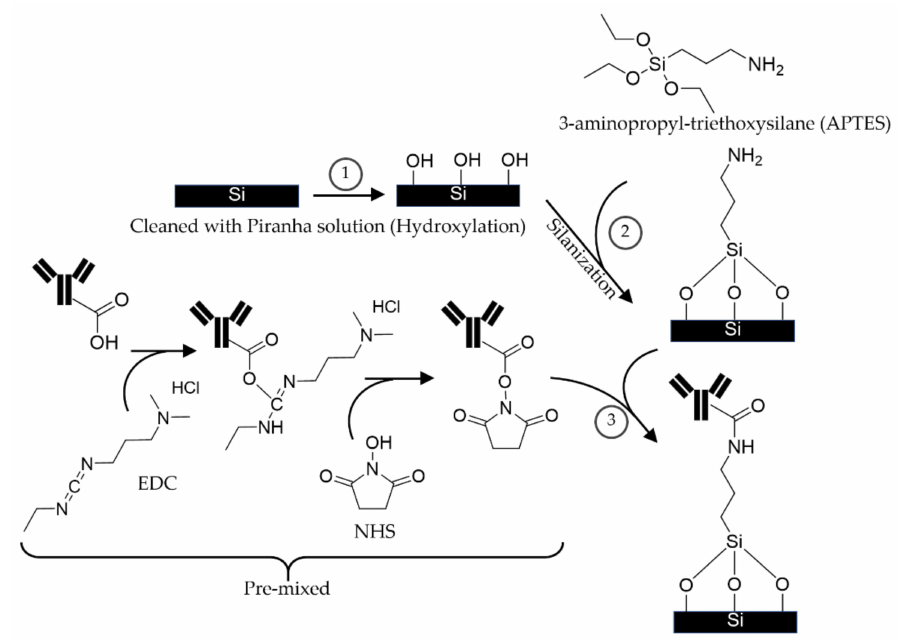
Figure 3. The procedure for the proposed rapid APTES-(EDC/NHS)